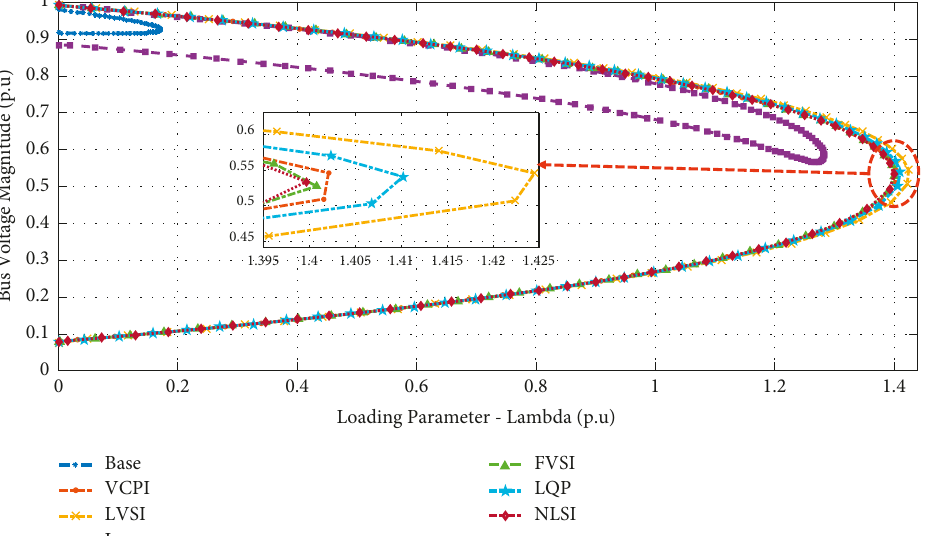
Figure 14: Maximum loadability in SC-1 by PV curves at Bus 30.